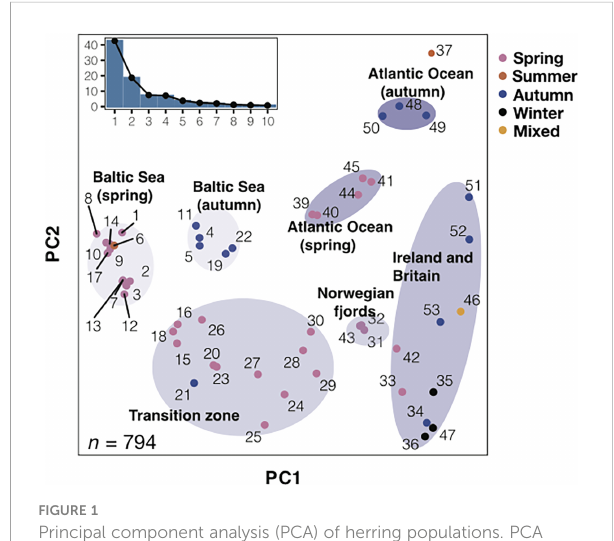
FIGURE 1 Principal component analysis (PCA) of herring populations. PCA based on 794 highly informative markers representing loci likely under natural selection. Color of each population represents spawning season. Inset bar plot indicates the percentage of explained variance by each principal component. n = number of SNPs used in the analysis. Adapted from Han et al., 2020, Figure